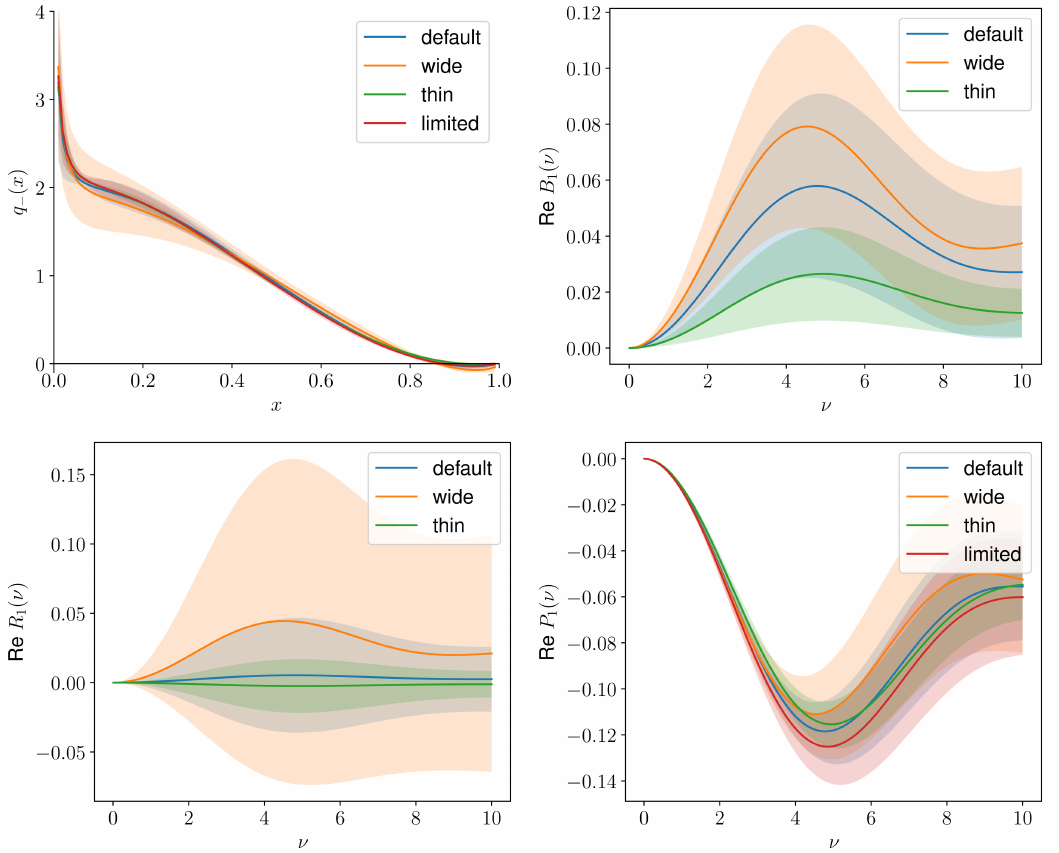
Figure 10 . The results of fitting to the models of table 3. The PDF is given by the upper left, B 1 ( ν ) is given by the upper right, R 1 ( ν ) is given by the lower left, and P 1 ( ν ) is given by the lower